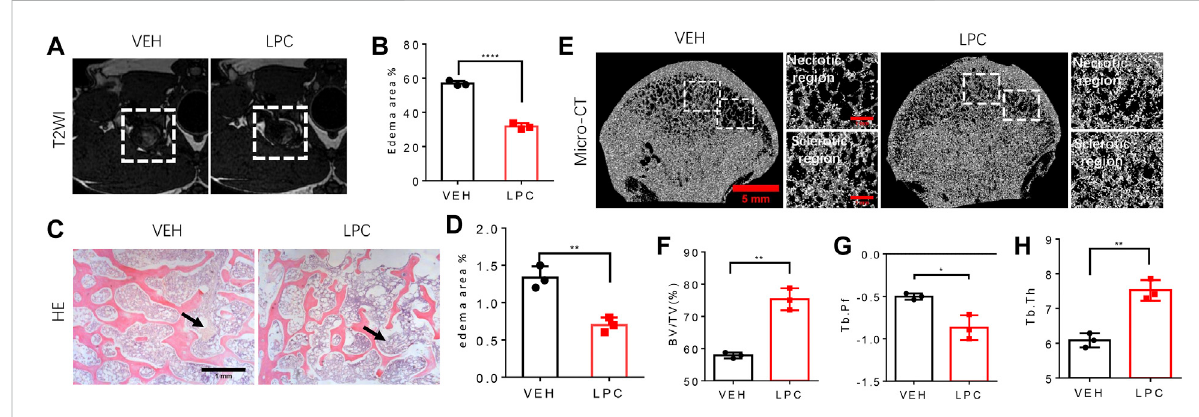
FIGURE 6 The function of LPCs in bone structure improvement. (A) T2WI images of the femoral head from control group and LPCs-treated group. (B) Quantitativeanalysisofedemaareaoftwogroups.**** P ＜ 0.0001. (C) HE-staining show theedemadegree inthemedial positionoffemoralheadin control group and LPCs-treated group, and the black arrow point at the edema area. (D) Quantitative analysis of edema area in control group and LPCs-treatedgroup.** p =0.0039. (E) Representative3-dimensionalmicro-computedtomography( μ CT)imageofcoronalviewofthefemoral head in control group and LPCs-treated group. The white frame in the subchondral bone region, point out the necrotic region, and sclerotic region, respectively. (F) Quantitative analysis of bone volume /tissuevolume (BV/TV)ratio, ** p = 0.001, (G) trabecular pattern factor (Tb. Pf), * p = 0.0133, (H) trabecular thickness in control group and LPCs-treated group. ** p = 0.0023, n =